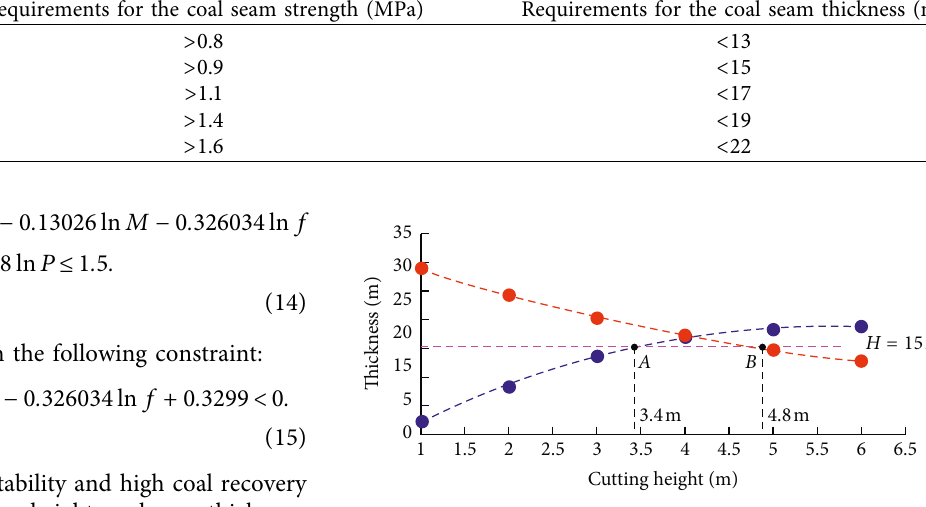
Figure 7: Relationship between coal seam thickness and cutting height ( f � 2.2; P � 1 . 45 MPa; H �